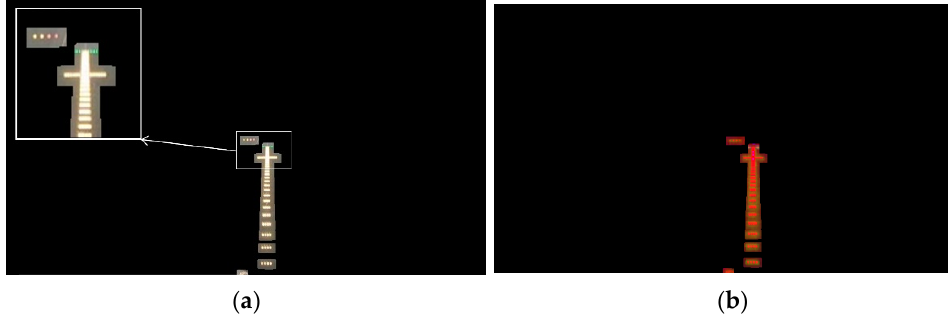
Figure 7. RGB vs. HSV coding: ( a ) colors are weakly visible in the RGB picture; ( b ) the same picture, once converted to the HSV scale.